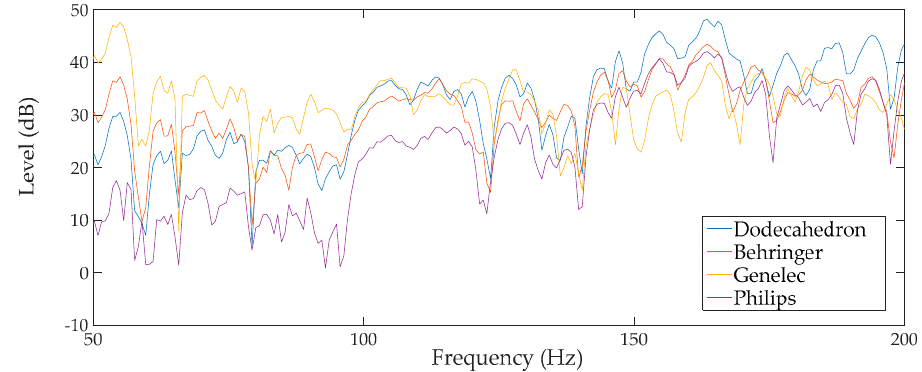
Figure 13. Frequency responses for measurements with the dodecahedron speaker and the proposed method with different speakers.